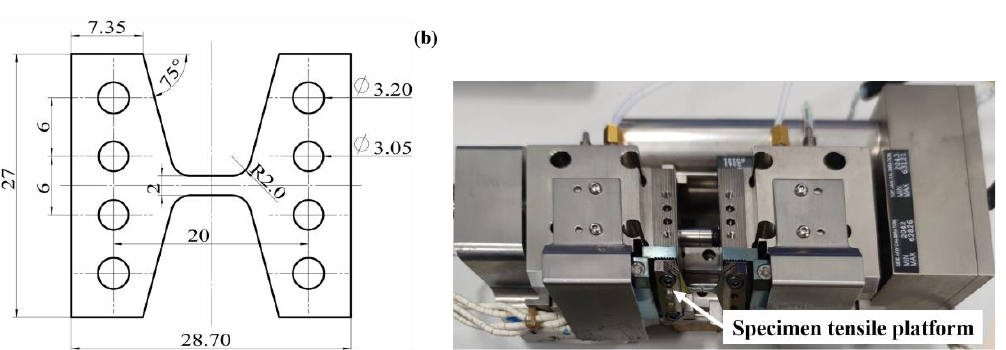
Figure 1. ( a ) Schematic diagram (in mm) of the in situ tensile test specimen. ( b ) In situ EBSD tensile system.